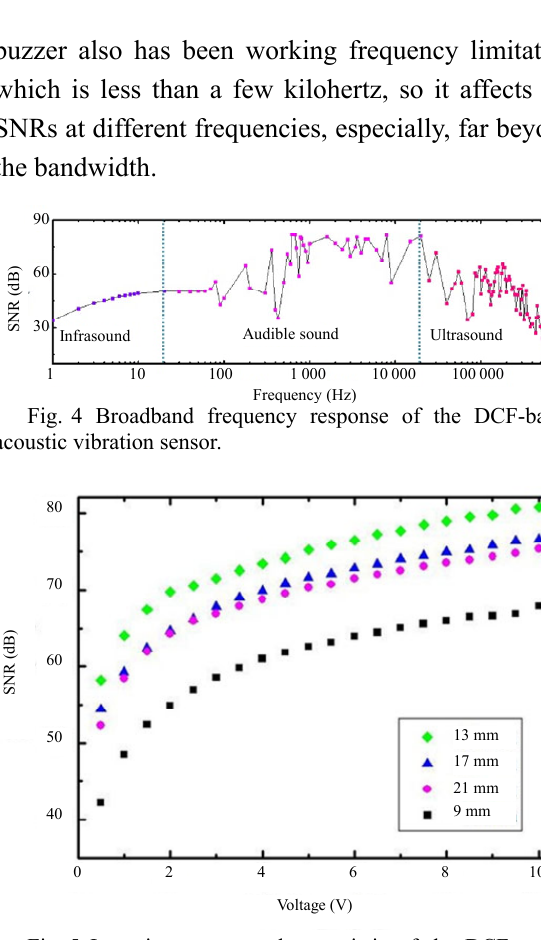
Fig. 5 Intensity response characteristic of the DCF sensor with 9 mm, 13 mm, 17 mm and 21 mm access length, the intensity range is from 0.5 V to 10 V when the frequency is 20